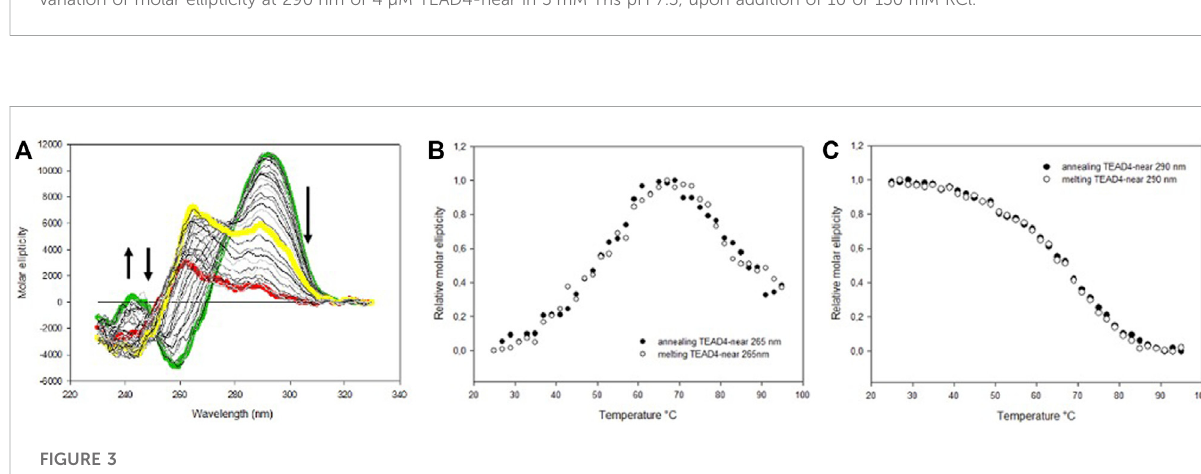
FIGURE 2 (A) Time dependentvariation of CD spectraof 4 µM TEAD4-near in 5 mM Tris pH 7.5, upon addition of 150 mM KCl recorded at 25 ° C. Solid and dashed lines correspond to the oligonucleotide in the absence of metal ion and after 1 h incubation, respectively. (B) Time dependent relative variation of molar ellipticity at 290 nm of 4 µM TEAD4-near in 5 mM Tris pH 7.5, upon addition of 10 or 150 mM KCl.